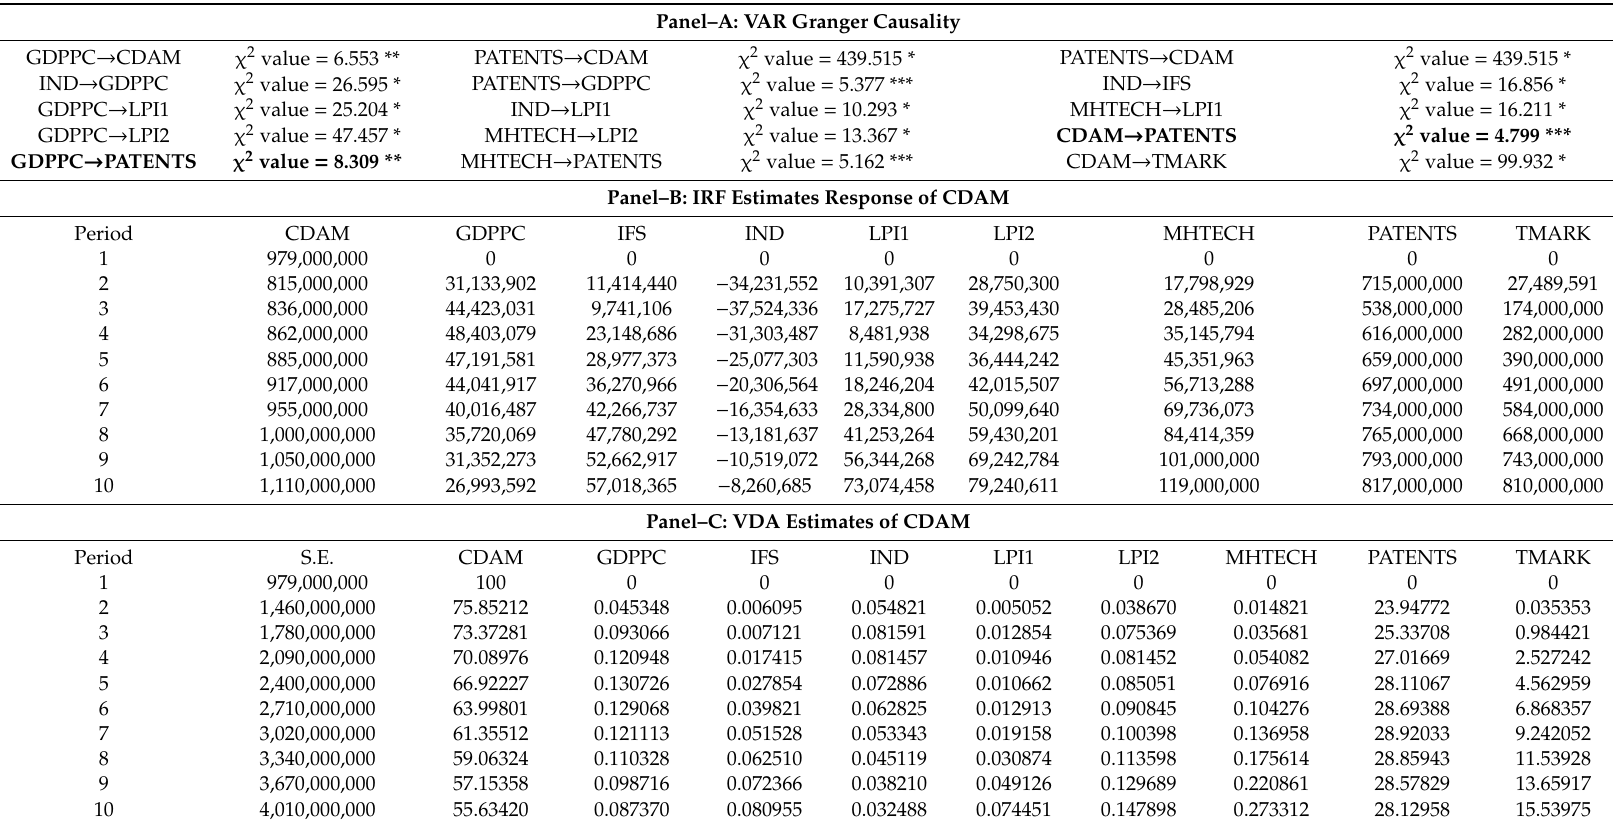
Table 7. VAR Granger Causality, impulse response function (IRF), and variance decomposition analysis (VDA) Estimates. Panel–A: VAR Granger